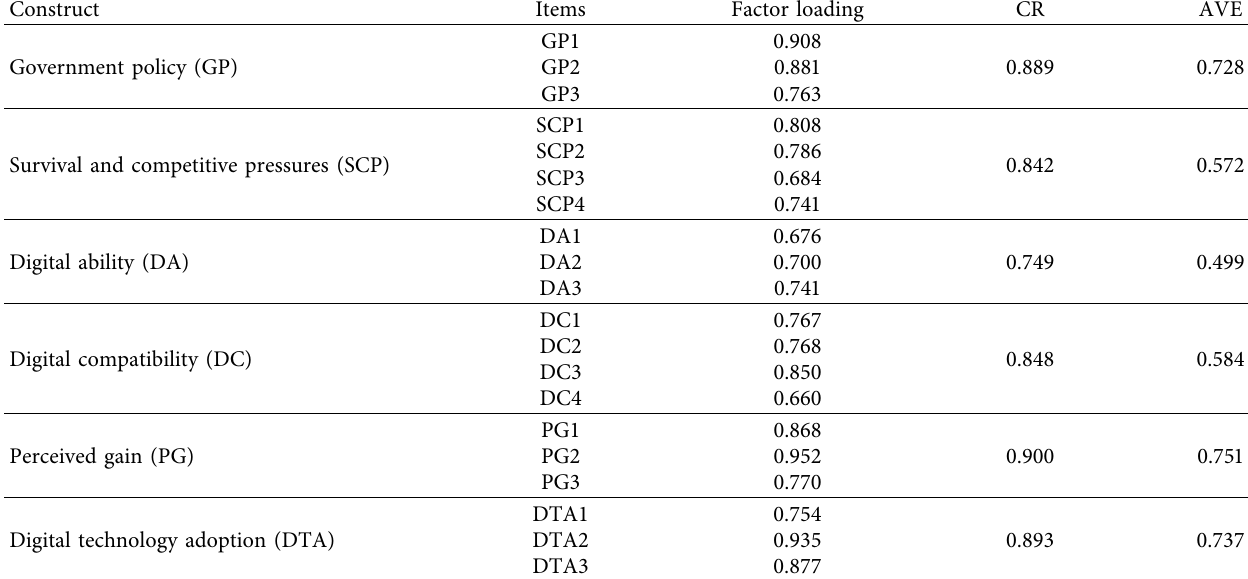
Table 1: Reliability and convergent